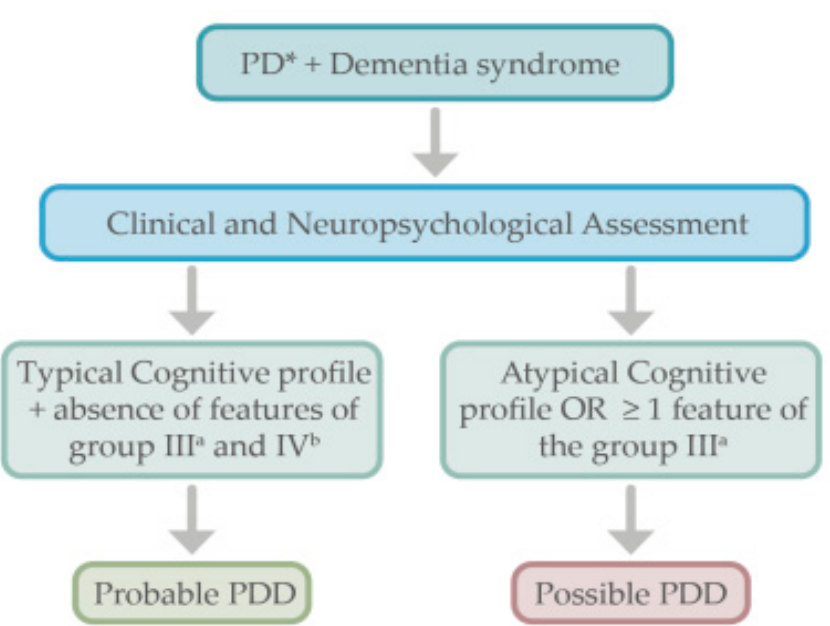
Figure 1. Proposed algorithm for the diagnostic approach in Parkinson’s disease dementia. * Par-